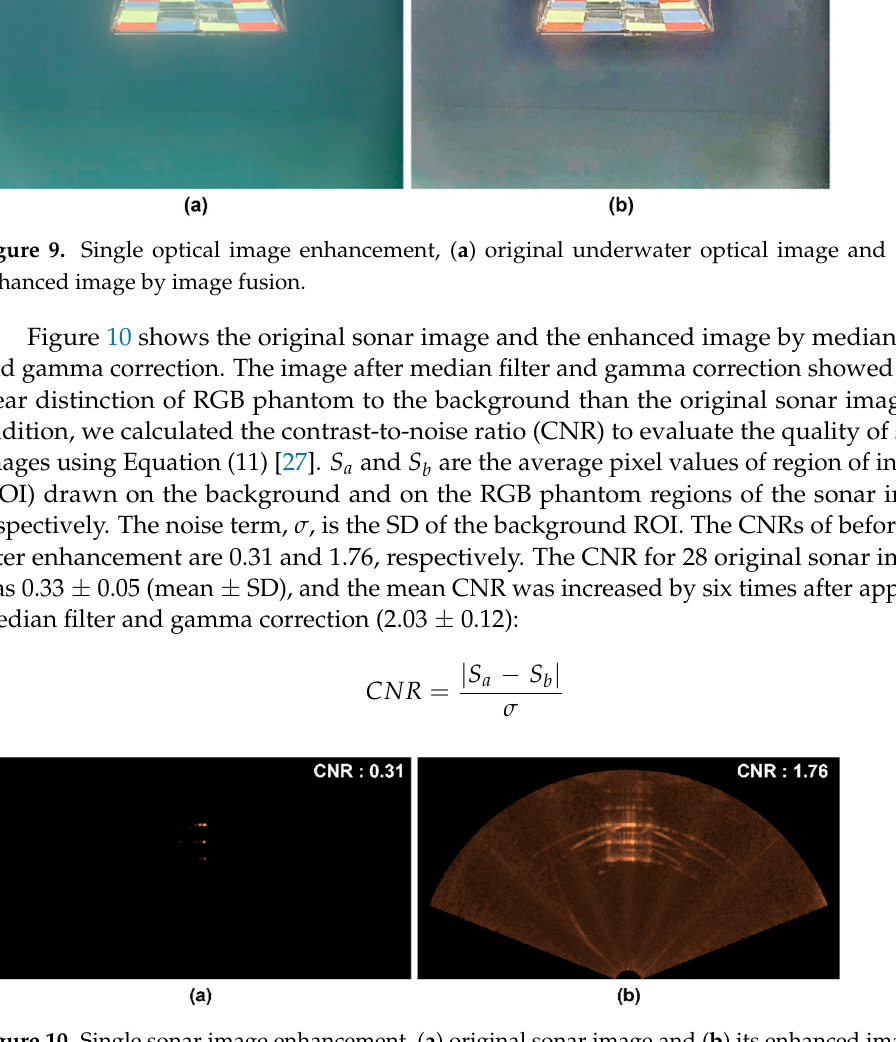
Figure 10. Single sonar image enhancement, ( a ) original sonar image and ( b ) its enhanced image by median filter (5 × 5) and gamma correction ( 𝜸 𝟐 = 0.2).